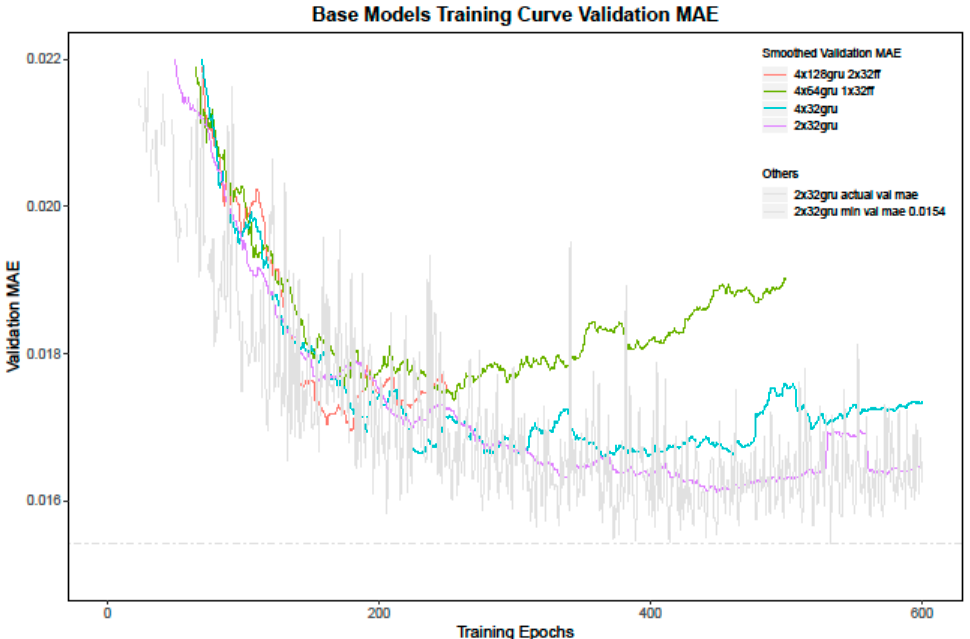
Figure 11. Base model training curves (training curves are smoothed using 20-epoch moving average; the background plot is the actual training curve of the best model).